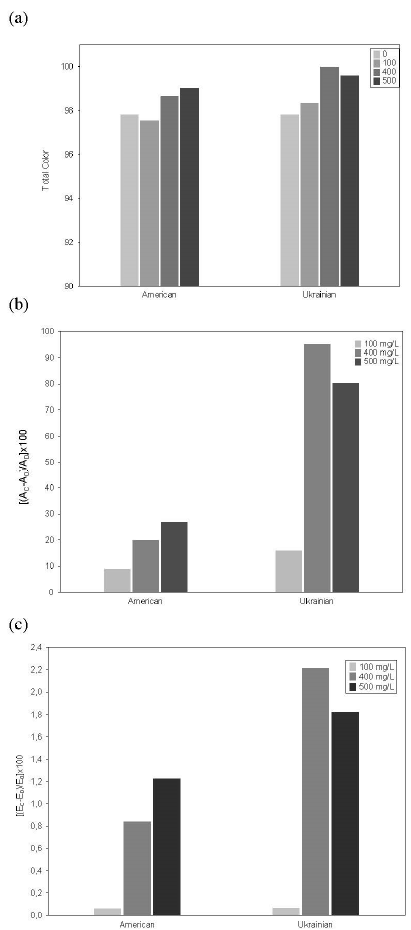
Figure 2. ( a ) Total color, ( b ) magnitude of copigmentation evaluated by the absorbance at 520 nm ( c ) and by tristimulus colorimetry of the control solution and model solutions with different TPC.